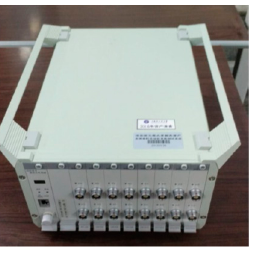
Figure 5. Data acquisition device.